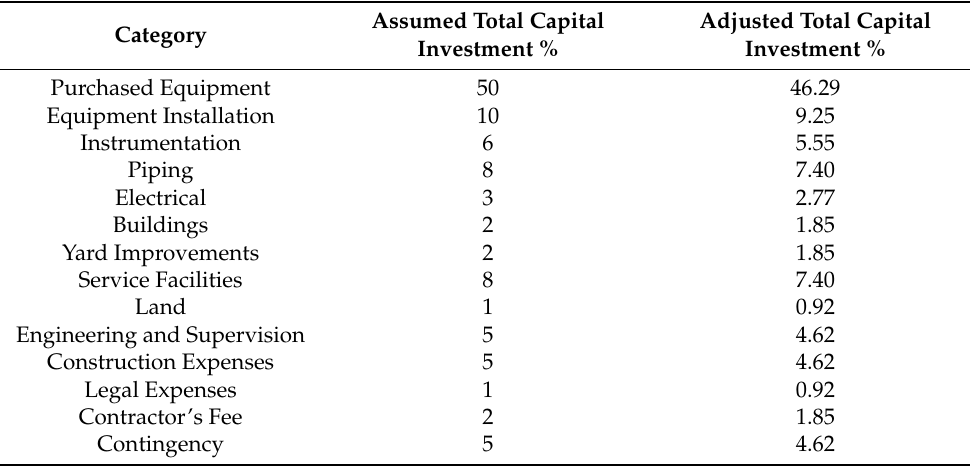
Table 1. Total Capital Investment